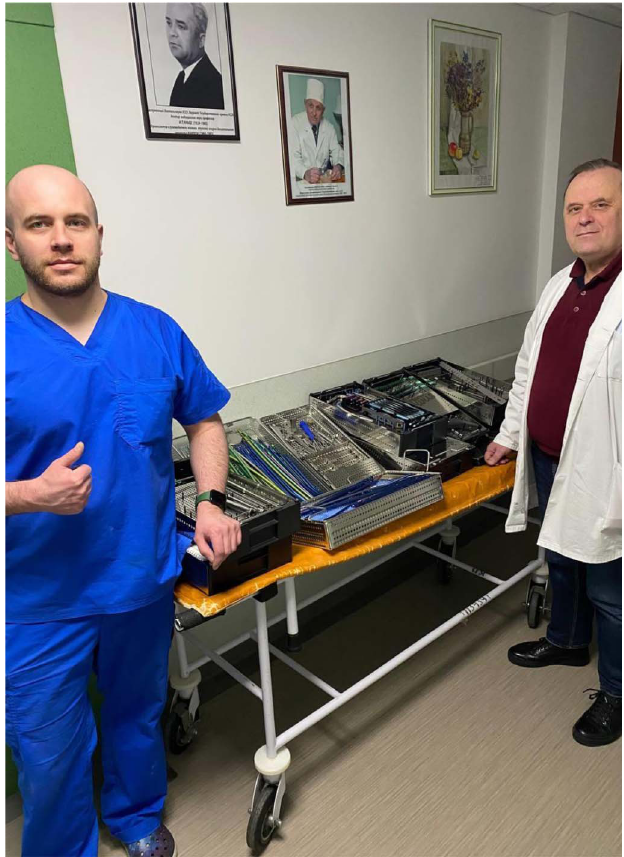
Figure 2. Maksymenko Bohdan and Igor Volkov from Bogo- molets National Medical University (NMU) Kyiv, Ukraine with the received osteosynthesis material. From left to right: Maksy- menko Bohdan, resident, and Igor Volkov, Chairman, Oncology Orthopedic Department, National Cancer Institute, Kyiv, Ukraine. Both physicians gave permission that this picture is